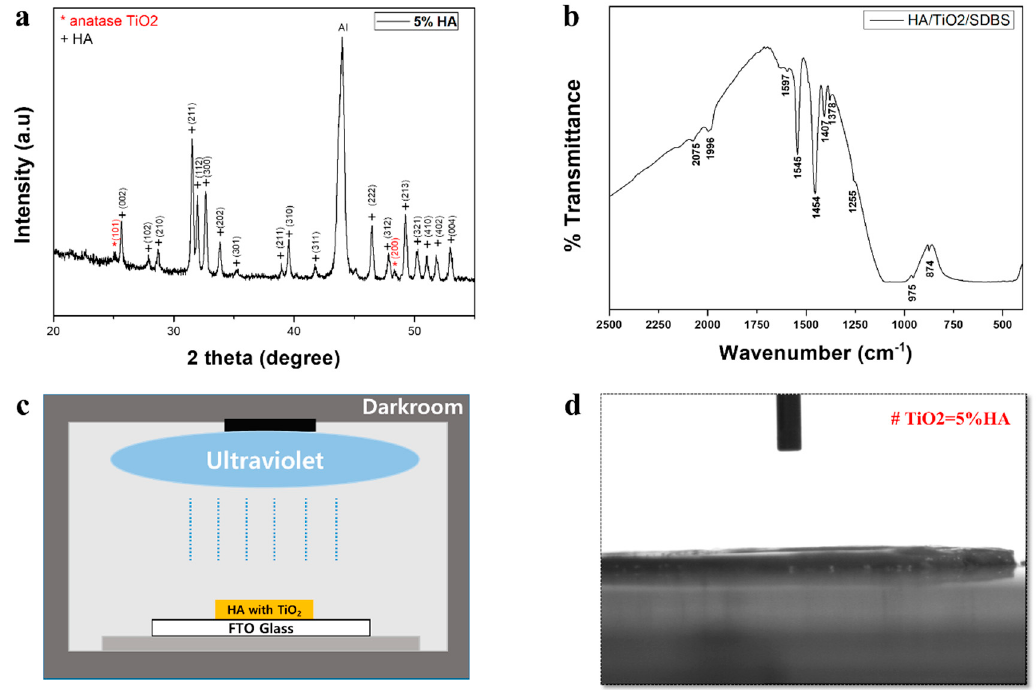
Figure 1. ( a ) X-ray diffraction spectroscopy (XRD) analysis. Anatase TiO 2 is present in TiO 2 -coated HA. ( b ) Fourier transform infrared spectroscopy (FTIR) measurement to check the biocompatibility of the combined graft material. ( c ) Photofunctionalization of TiO 2 -coated HA particles by irradiating with ultraviolet light for 1 min using a photo device. ( d ) Wettability test. For the 5% TiO 2 sample in the mixture, the contact angle was maintained at 0°.